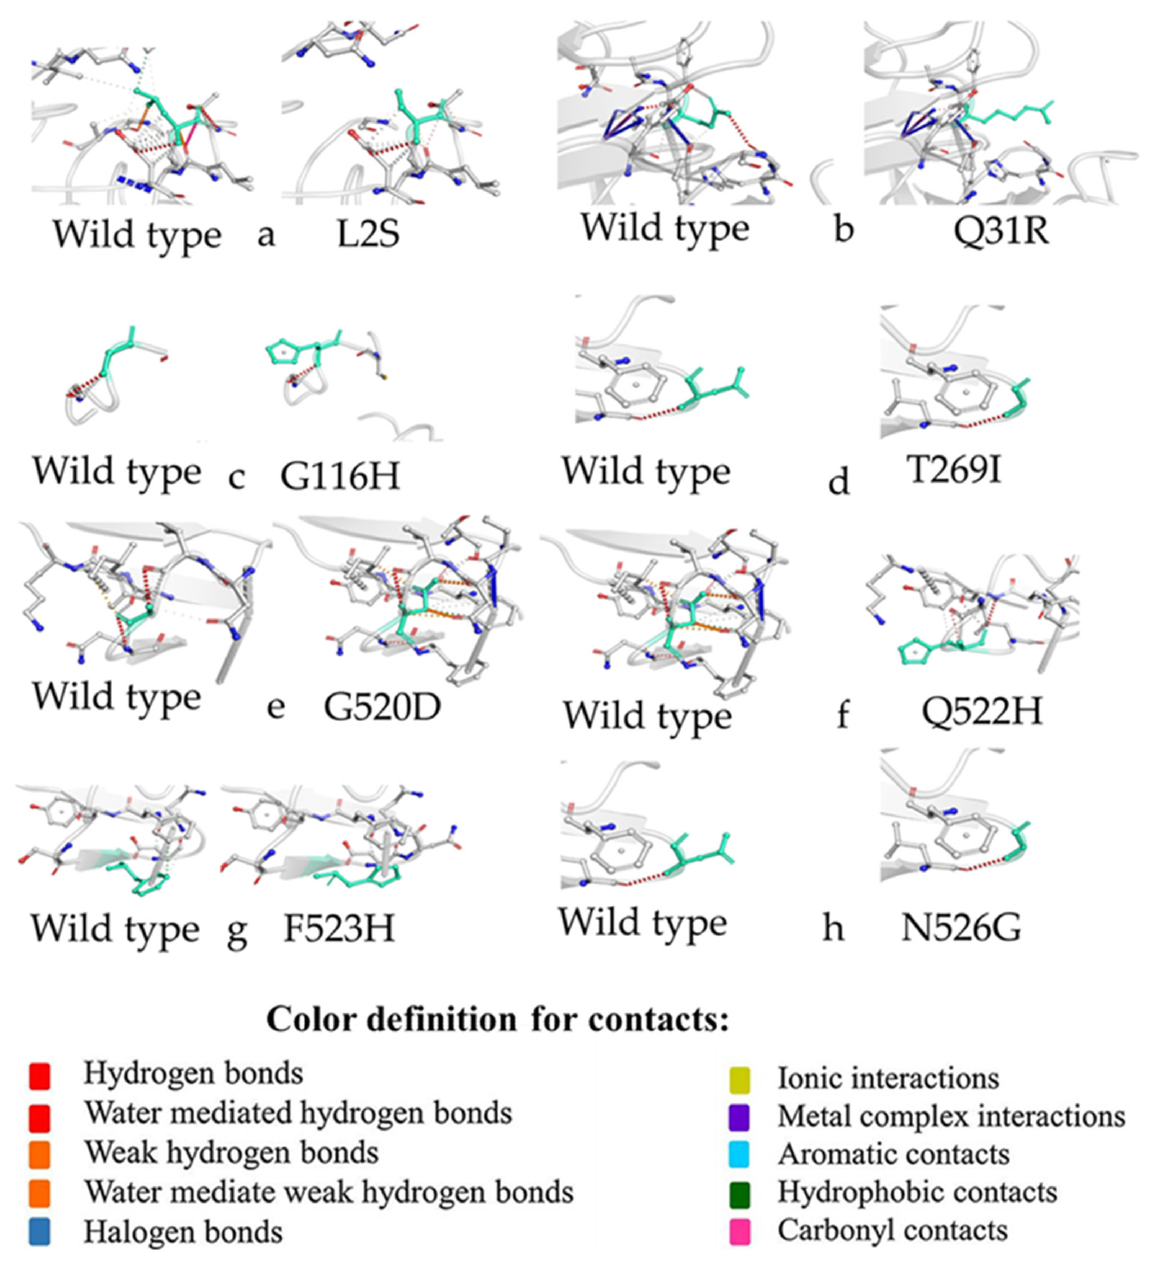
Figure 4. Prediction of interatomic interactions of the wildtype S1 protein vs. the mutant one using DynaMut. Non-mutant and variant aa residues (from a – h ) are shown in light green and appear as sticks associated with the remaining residues forming the interaction. Dot points of several colors refer to the types of interactions.